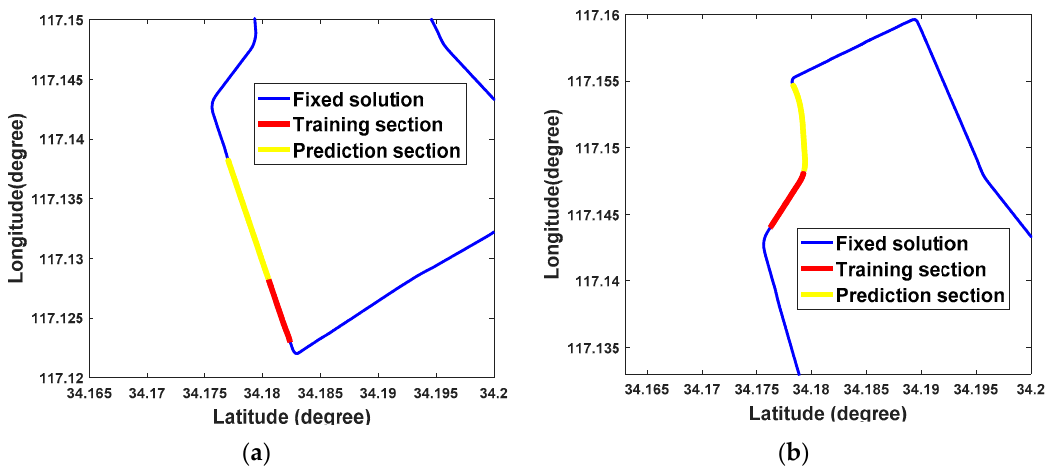
Figure 9. The corresponding route in Test 1 trajectory ( a ) and Test 2 trajectory ( b ).